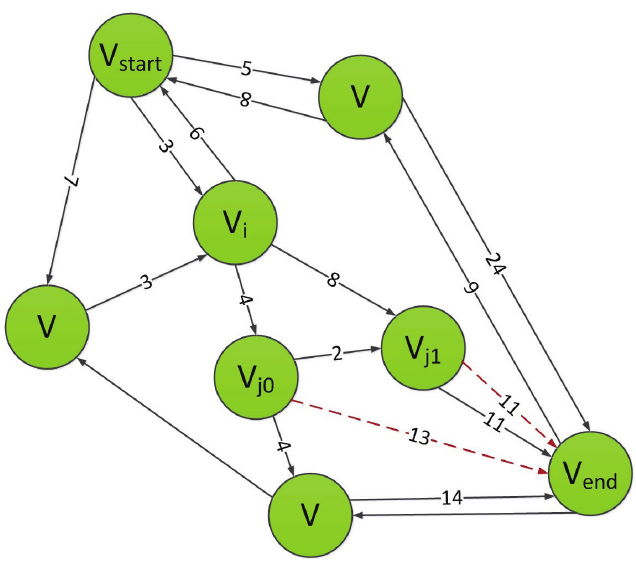
Figure 4. Illustration of the A* evaluation function.